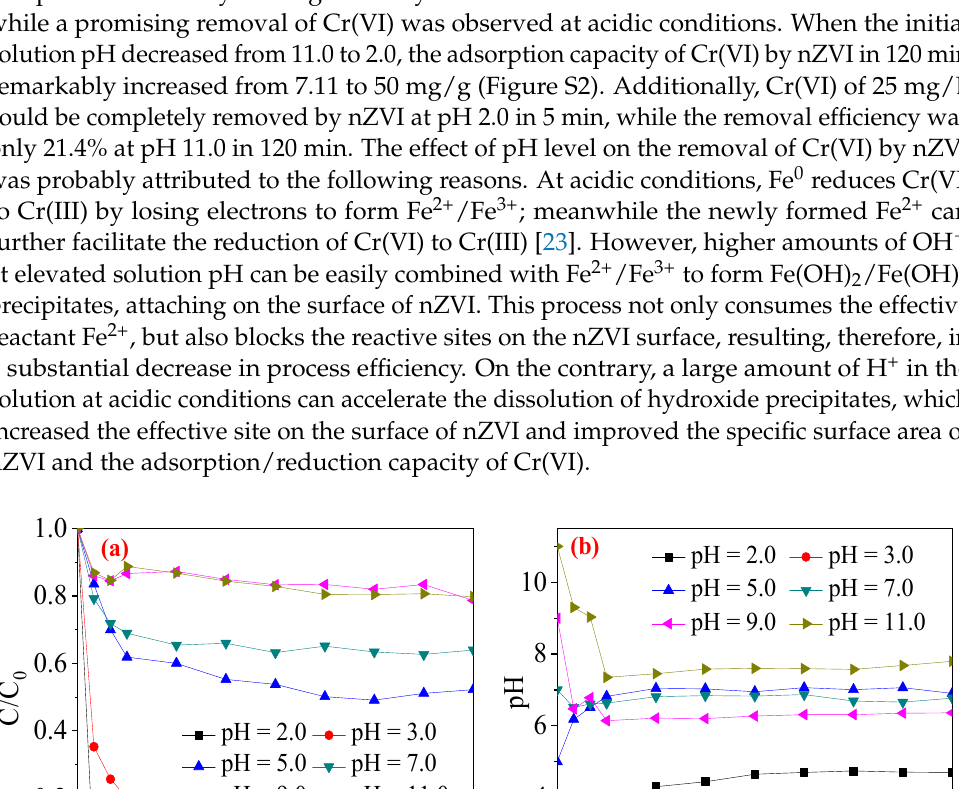
Figure 2. The XRD spectrogram of nZVI.